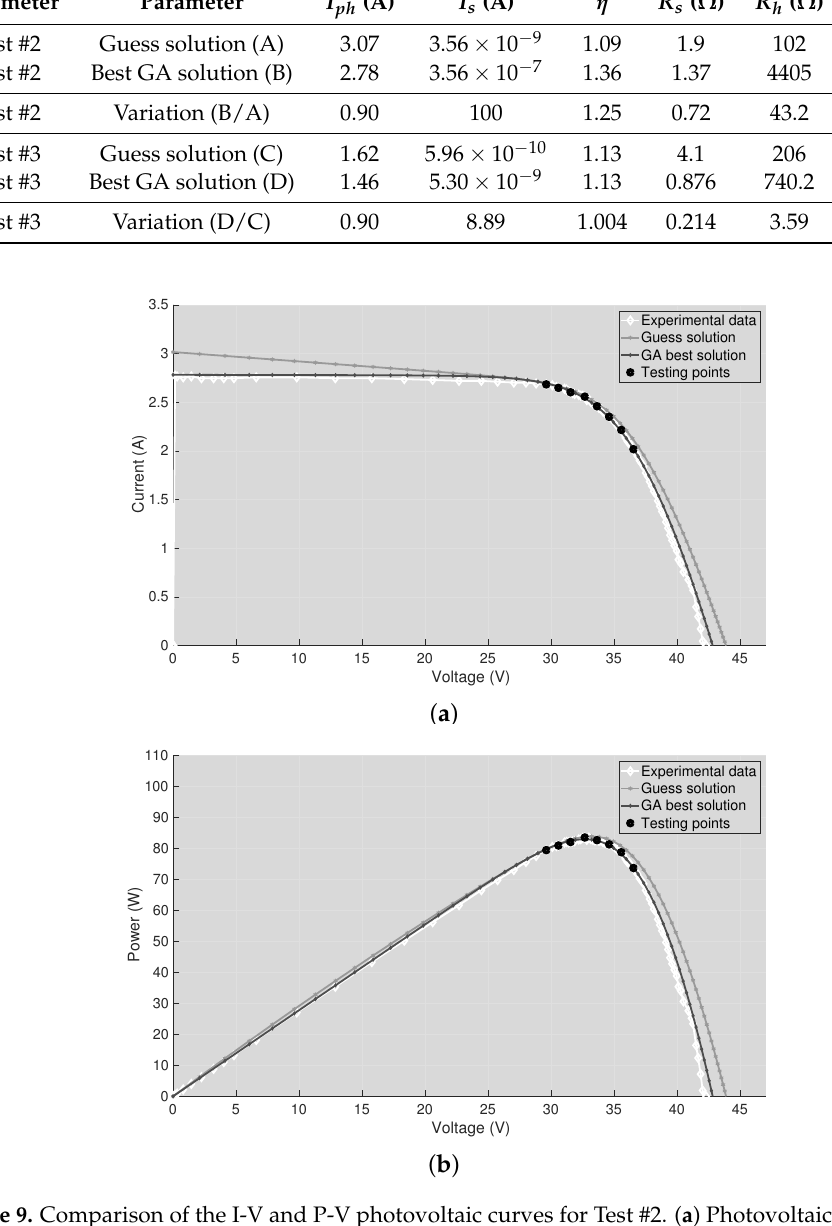
Figure 9. Comparison of the I-V and P-V photovoltaic curves for Test #2. ( a ) Photovoltaic I-V curves; ( b ) photovoltaic P-V